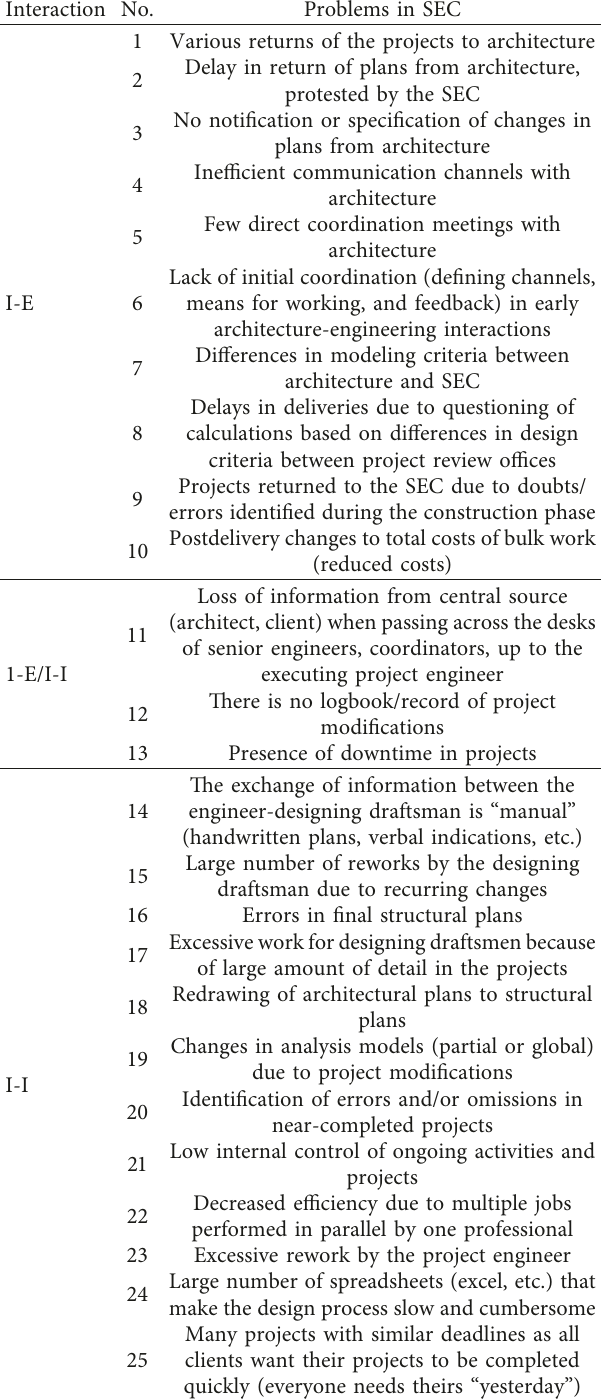
Table 2: Typical problems in structural engineering companies (SEC)